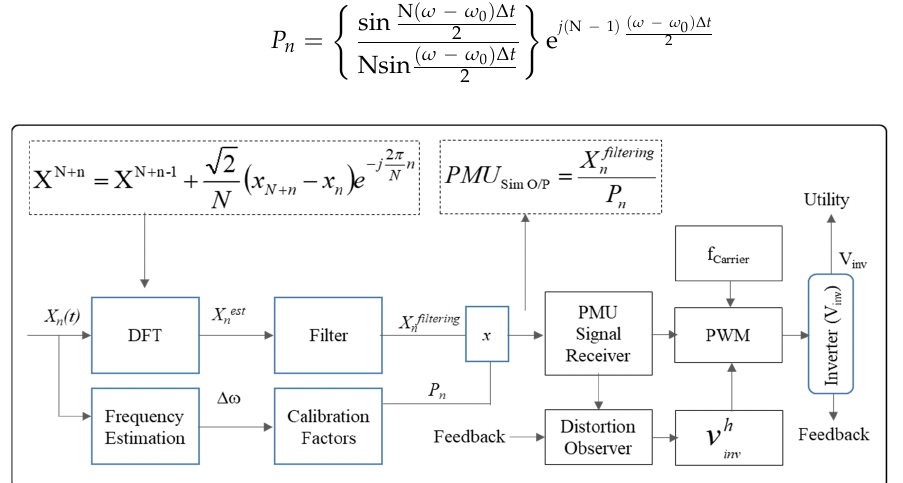
Figure 4 . PMU processing algorithm for uniform sampling. Figure 4. PMU processing algorithm for uniform